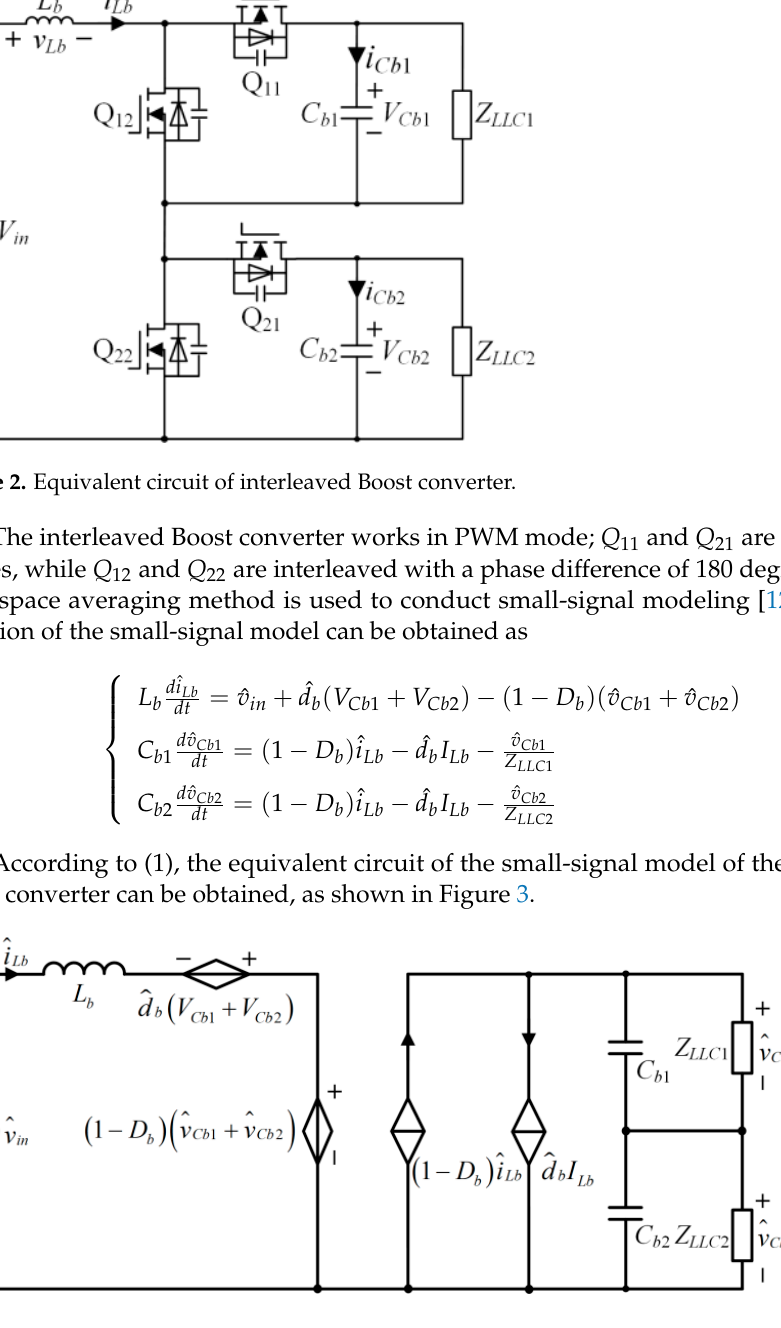
Figure 3. Small-signal equivalent circuit model of interleaved Boost converter.